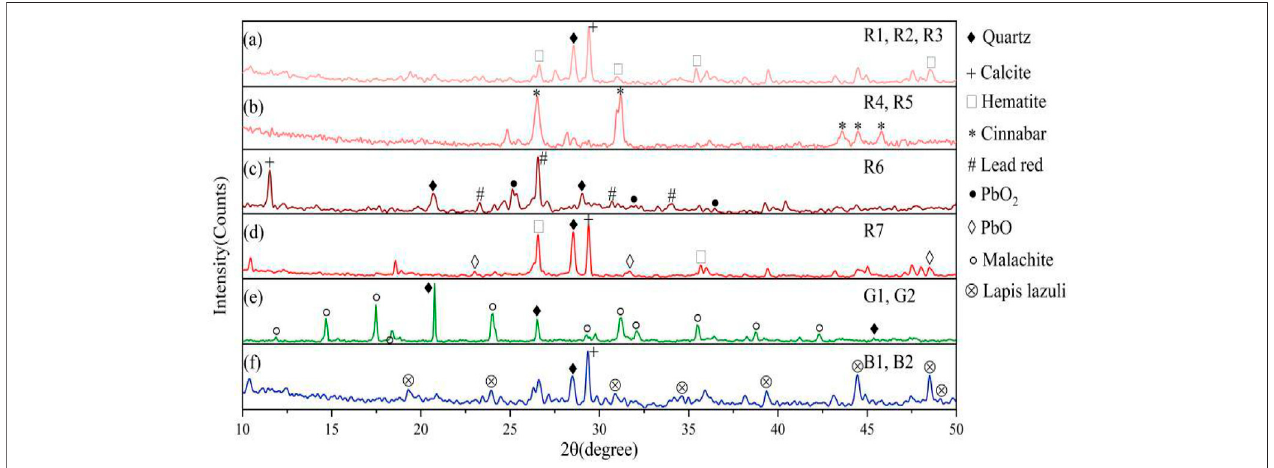
FIGURE 7 | X-ray diffraction (XRD) patterns of pigments in red (A – D) , green (E) , and blue (F) areas on murals in caves.